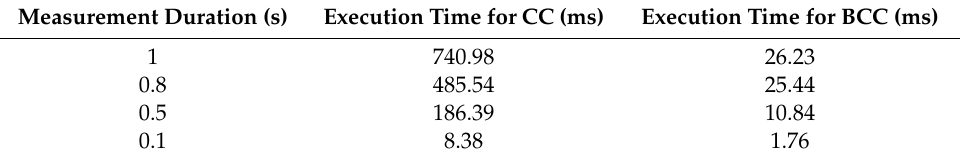
Table 10. Execution time for di ff erent measurement